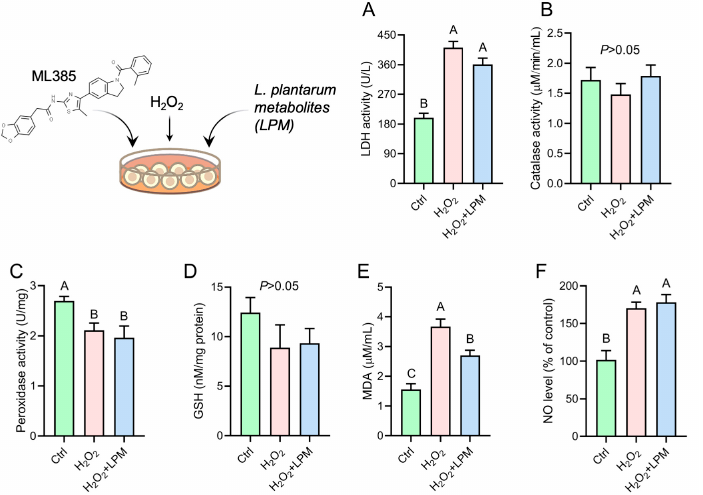
Figure 6. Effects of L. plantarum metabolites (LPM) on the ( A ) lactate dehydrogenase (LDH) leakage; ( B ) catalase activity; ( C ) peroxidase activity; ( D ) glutathione level; ( E ) malondialdehyde (MDA) release; and ( F ) nitric oxide (NO) release in HepG2 cell that was treated with hydrogen peroxide (H 2 O 2 ) and pretreated with ML385, a pharmacological inhibitor of nuclear factor erythroid 2–related factor 2. Data represented as mean ± SEM of 3 measurements. Groups not sharing a common letter are significantly different ( p ≤ 0.05).